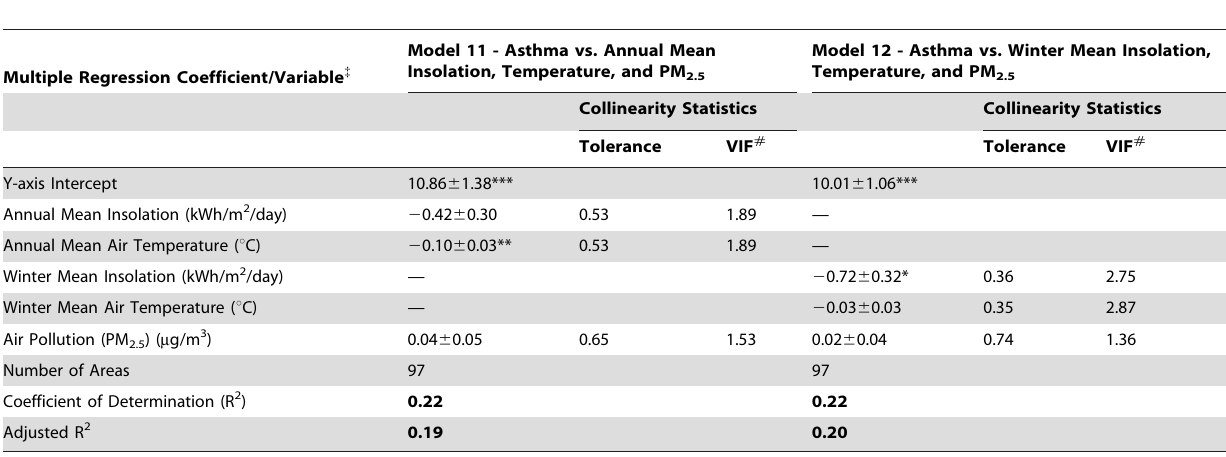
Table 4. Multiple regression estimates of asthma prevalence in US adult population associated with annual and winter mean insolation, annual and winter mean air temperature and air pollution (PM 2.5 ).